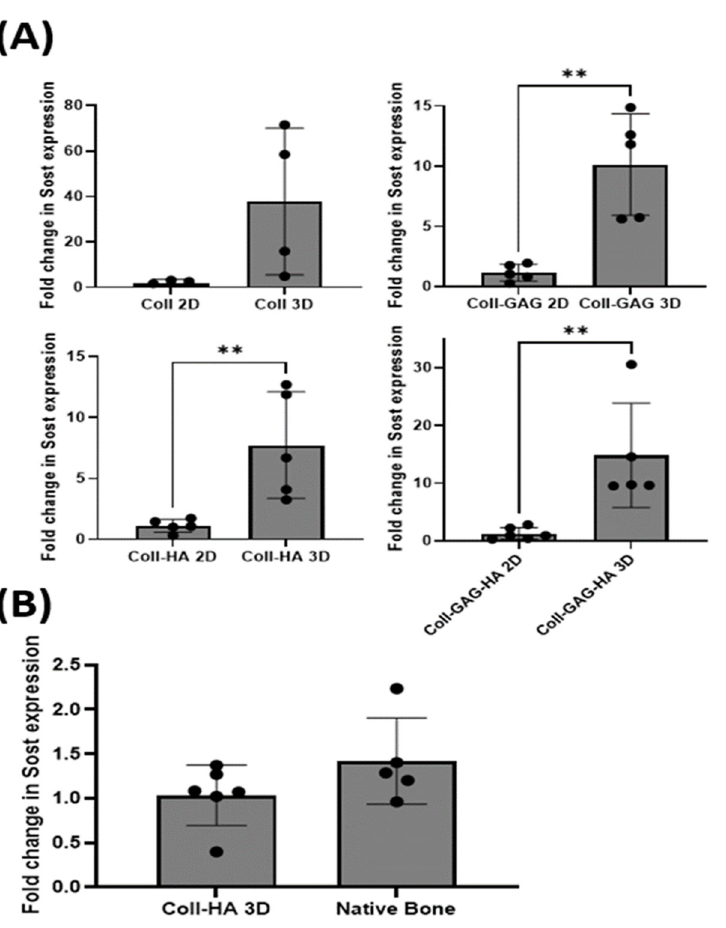
Figure 5. ( A ) MLO-Y4 Sost expression was higher in cells cultured on 3D ECM scaffolds relative to those on 2D thin films for all group composition studied. ( B ) No statistically significant difference existed between the Sost expression of cells cultured on Coll-HA 3D scaffolds compared to native bone. ( n = 4–6; ** p < 0.01) .